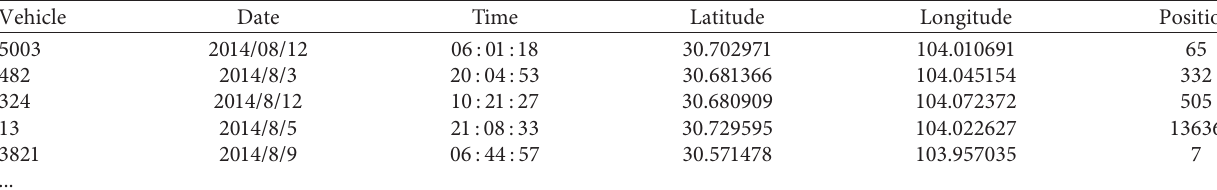
Table 2: GPS vehicle data.